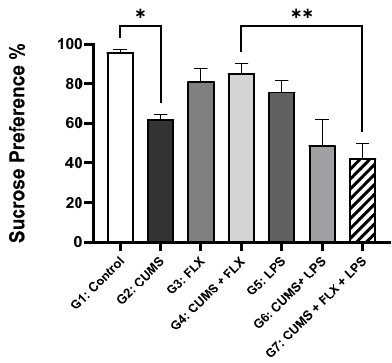
Figure 5. Effects of Lipopolysaccharide on Sucrose Consumption in Fluoxetine Treatment Resistant Depressive Rats: Data are expressed as the means ± SEM, n = 5. Group comparisons were performed using one-way ANOVA, followed by a Turkey – Kramer post hoc test; * p < 0.05 compared to control non-stressful group (group 1); ** p < 0.01 compared to FLX-treated stressful group (Group 4). CUMS: chronic unpredictable mild stress; FLX: fluoxetine; LPS: lipopolysaccharide.